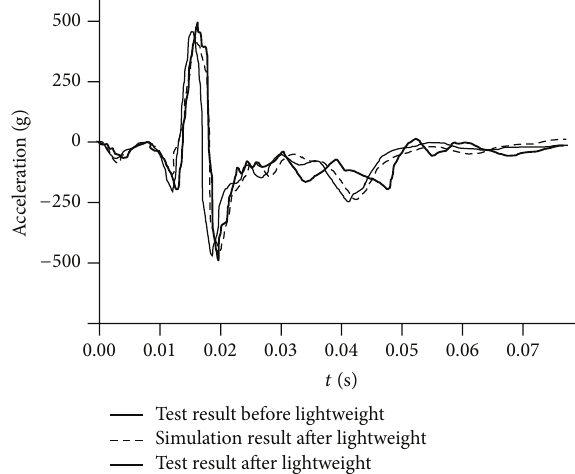
Figure 6: The collision acceleration of battery pack 1 bracket under rear-endcollisiontestbeforeandafterlightweightingthemainparts.